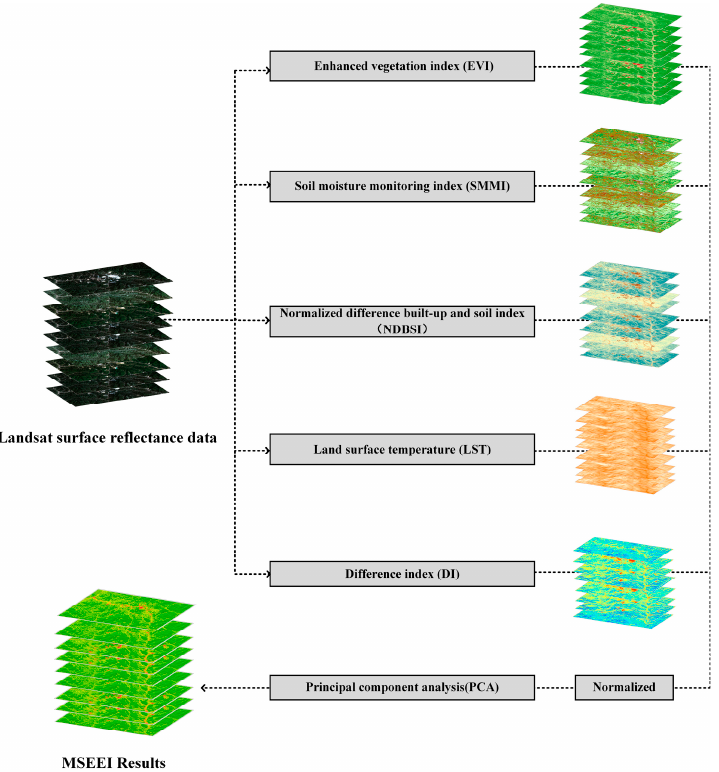
Figure 2. Flowchart of our MSEEI method.